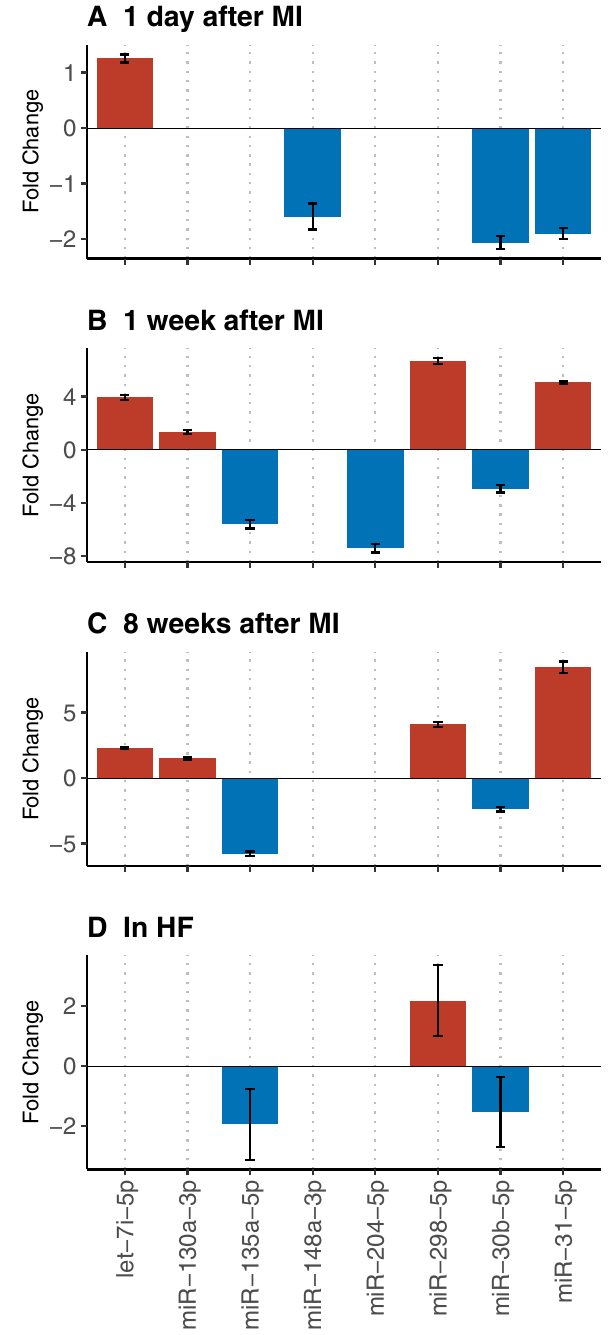
Figure 4. Expression of candidate miRNAs in mouse models of myocardial infarction (MI) and heart failure (HF). ( A - C ), Regulation of candidate miRNAs at 1 day, 1 week, and 8 weeks post MI. MI was induced by permanent ligation of the left anterior descending coronary artery in 8 weeks C57BL/6 male mice. Left ventricles were used for miRNA sequencing (GEO accession GSE114695). ( D ) Regulation of candidate miRNAs in HF. HF was induced by transverse aortic constriction (TAC) surgery in C57Bl/6 J mice. At 5 weeks after surgery, mice were sacrificed, and LV myocardium was used for miRNA sequencing (GEO accession GSE112054). Bars indicate fold changes in miRNA expression in MI or HF as compared to wt mice. Bars are only shown when significant regulation was observed. 3p and 5p indicates the origin of the miRNA from the 3’ arm or 5’ arm,